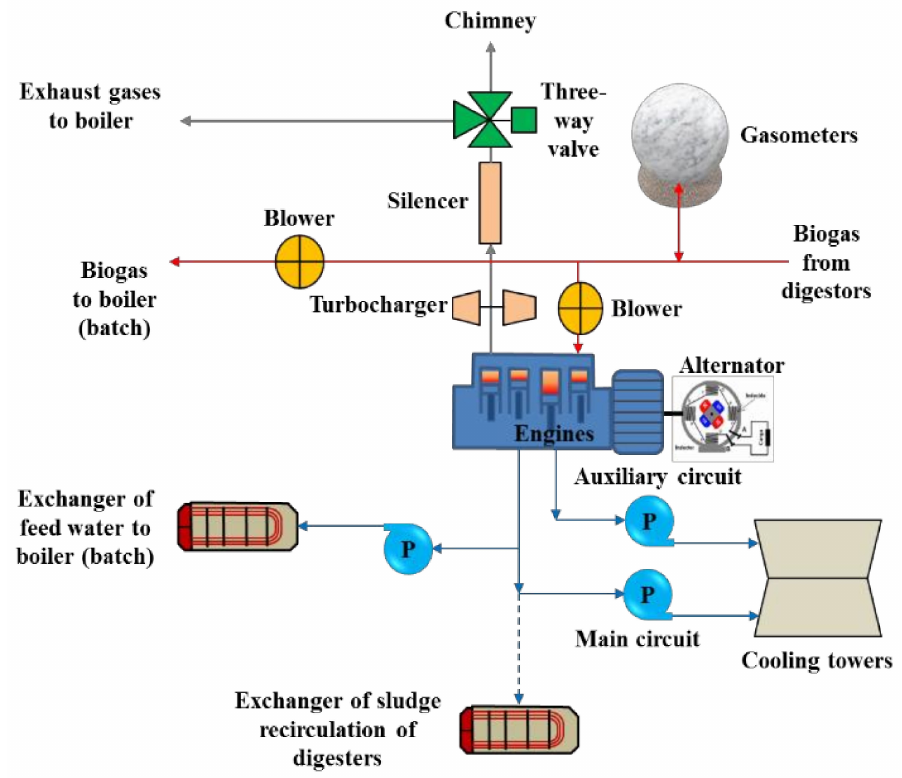
Figure 1. Scheme describing the general operating circuit of the biogas